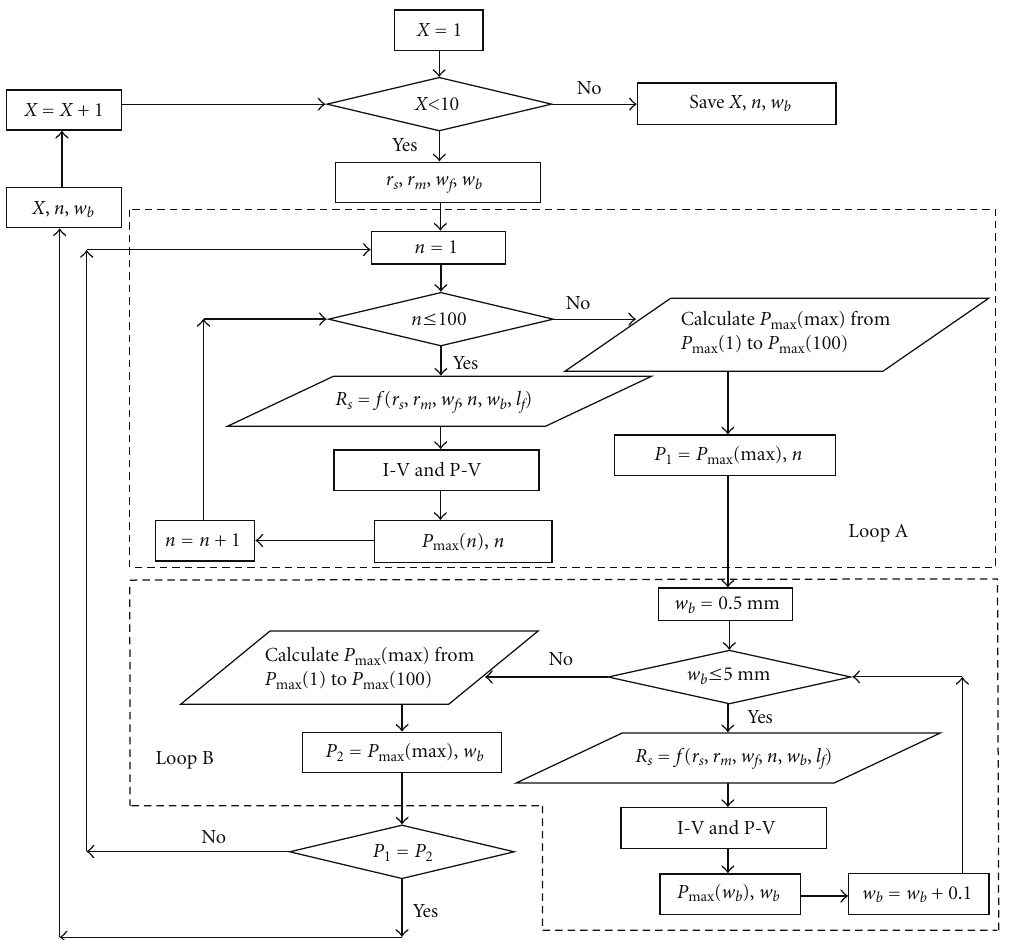
Figure 2: Flow chart for grid geometry